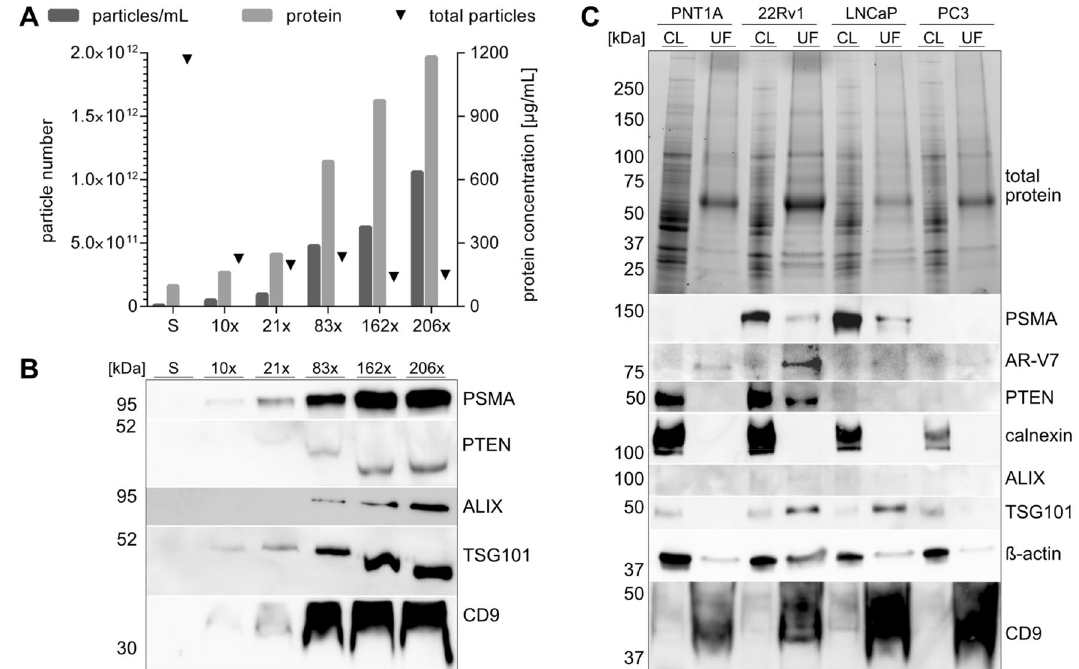
Figure 3. Analysis of increasing concentration of ultrafiltrated 22Rv1 supernatant (S) by NTA, protein concentration ( A ) and western blot ( B ). Characterization of total protein in SDS-PAGE and prostate-related and EV markers in western blot of ultrafiltrated supernatants of 5E+9 particles (UF) and 10 µg protein of cell lysates (CL) from PNT1A, 22Rv1, LNCaP and PC3 cells after serum-free incubation after 24 and 30 h, respectively ( C